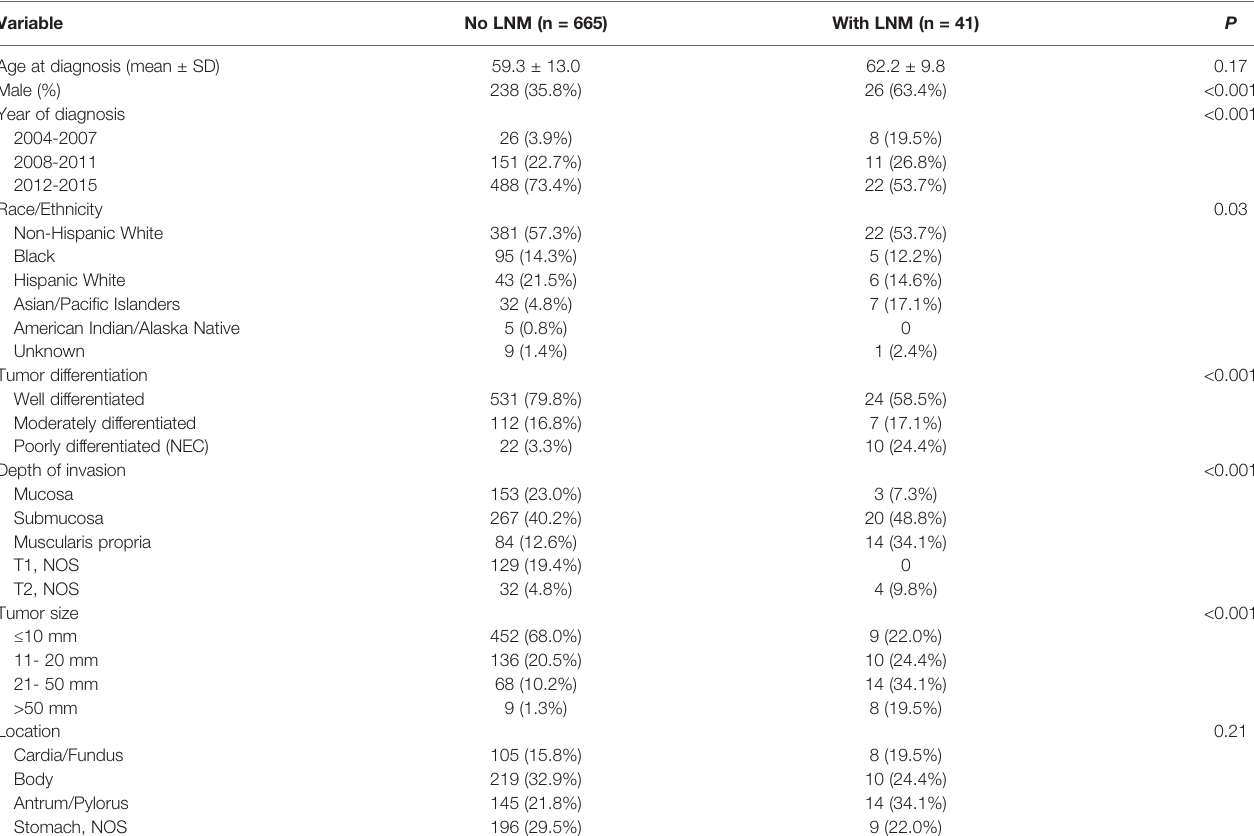
TABLE 1 | Characteristics of patients with T1/T2 g-NENs (n = 706) with and without LNM. Variable No LNM (n = 665) Age at diagnosis (mean ±